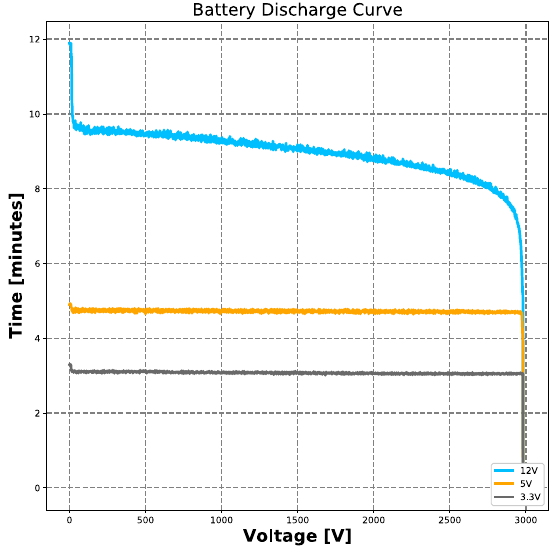
Figure 20. Graph of discharge curve running on battery mode.